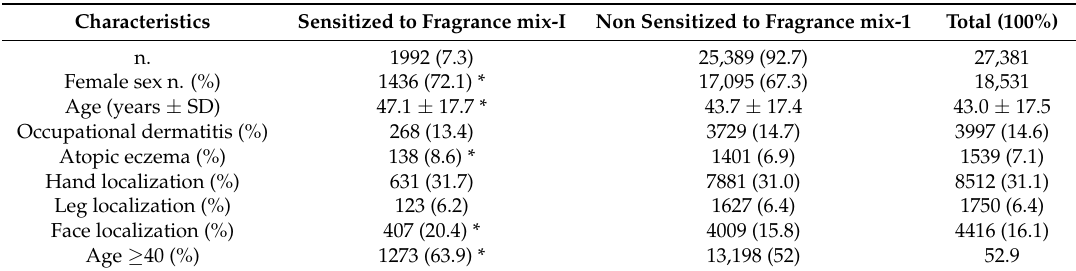
Table 1. Characteristics of the population tested (n = 27,381).